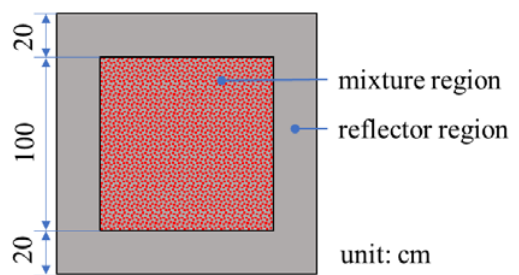
Figure 1. Geometry for calculation of k